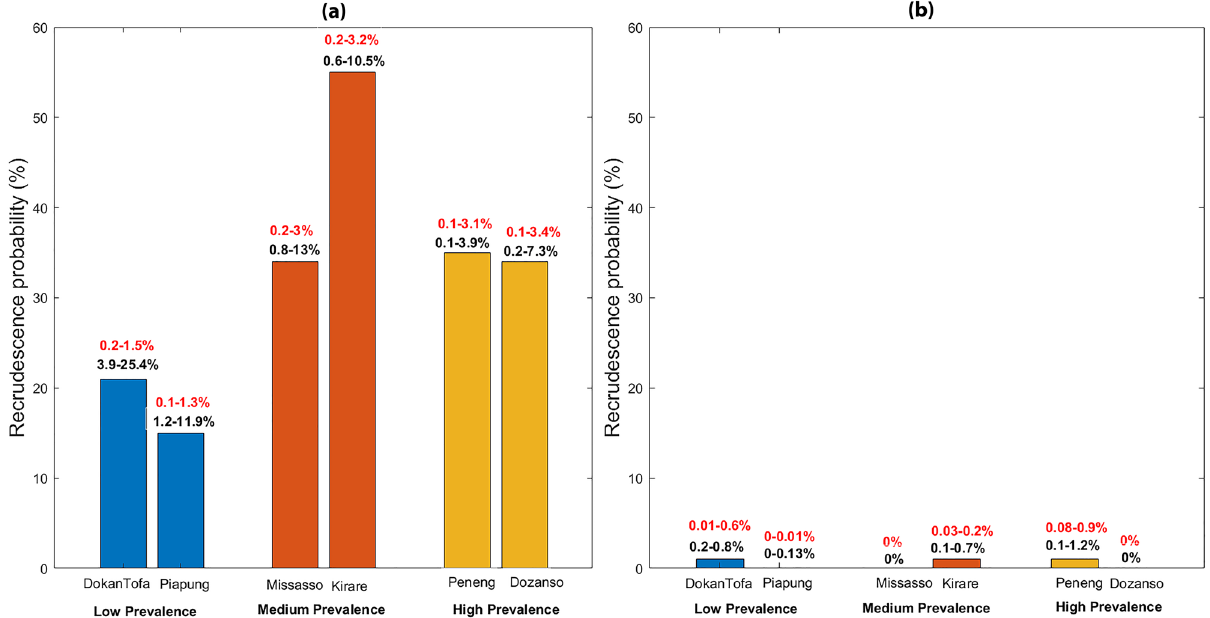
Fig. 3 Bar diagram of recrudescence probability for two low-prevalence (DokanTofa, Piapung), two medium-prevalence (Missasso, Kirare), and two high-prevalence (Peneng, Dozanso) study sites. a After 5 years of stopping annual MDA following breaching of the 1% mf threshold, and b after 5 years of stopping annual MDA following breaching of the 95% EP threshold as shown in Tables 1 and 2 and Supplementary Tables 4 and 5. Figures in red above each bar indicate the predicted ranges in mf prevalence while fi gures in black above each bar indicate the mf prevalence predicted as a proportion of baseline mf prevalence.